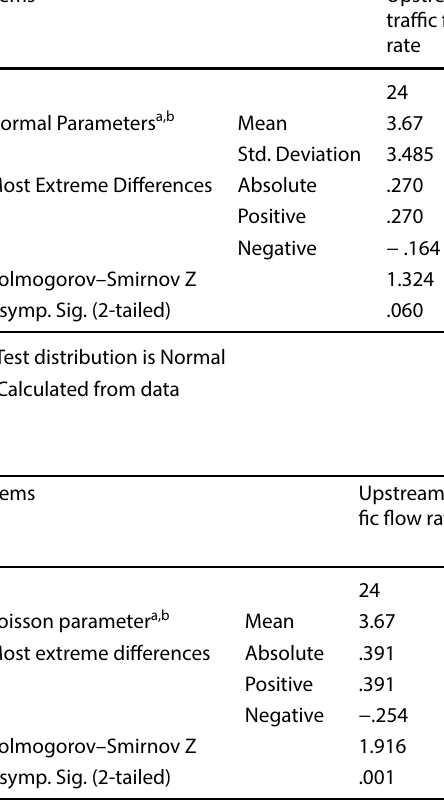
Table3 One-Sample Kolmogorov–Smirnov test of Normal distribution